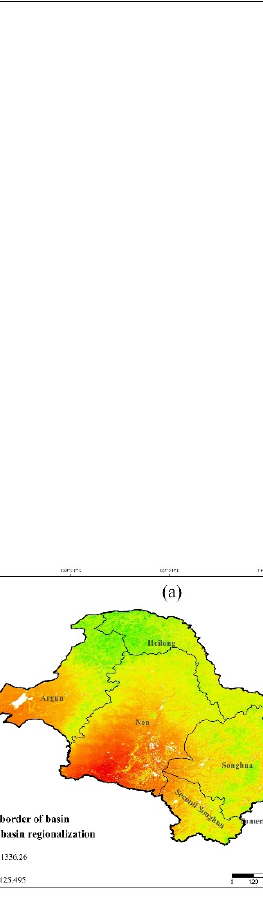
Figure 6. Spatial distributions of potential evapotranspiration (PET) and fractional vegetation coverage (FVC)/land use in the basin: ( a ) PET, ( b ) FVC, and ( c ) Land-use type.